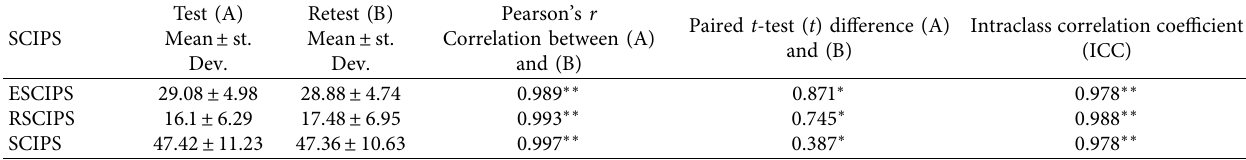
Paired t -test ( t ) difference (A) and ( Β )